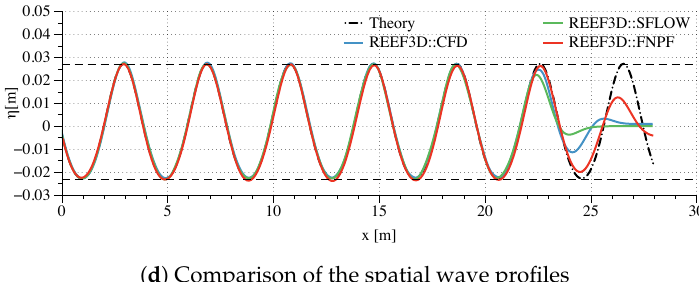
Figure 2. Convergence study on cell sizes for the 2D regular Stokes 2nd-order wave simulation and the comparison of free surface elevation among the three modules. ( a – c ) grid convergence study, ( d ) comparison of the spatial wave profiles using the cell sizes achieving grid